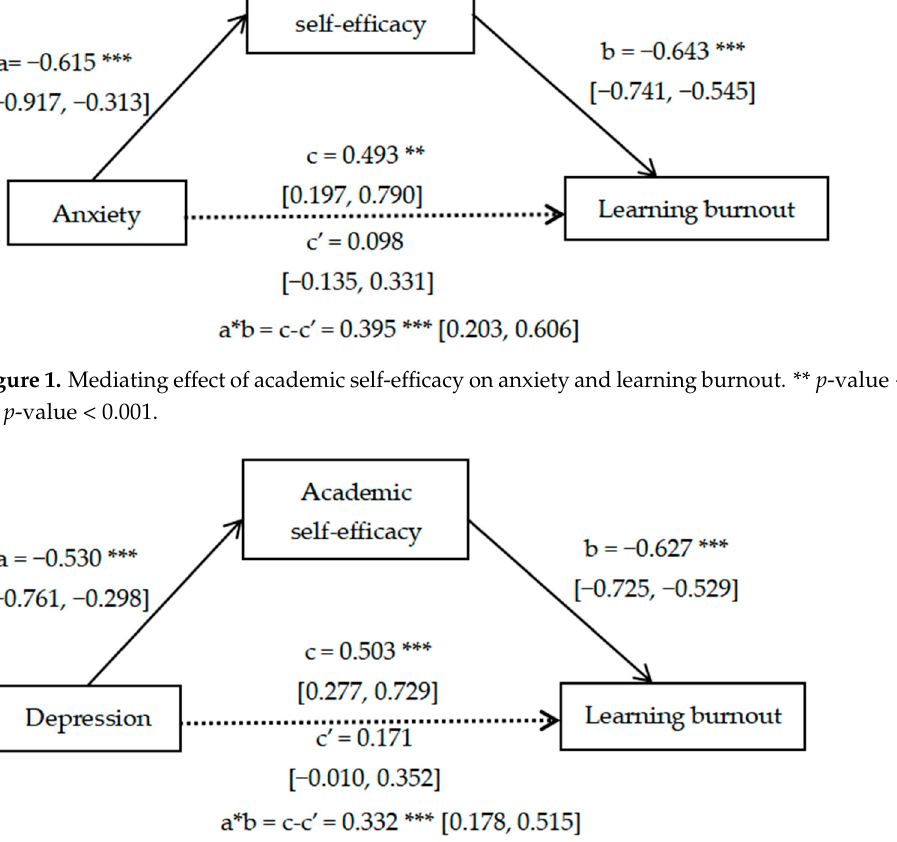
Figure 1. Mediating effect of academic self-efficacy on anxiety and learning burnout